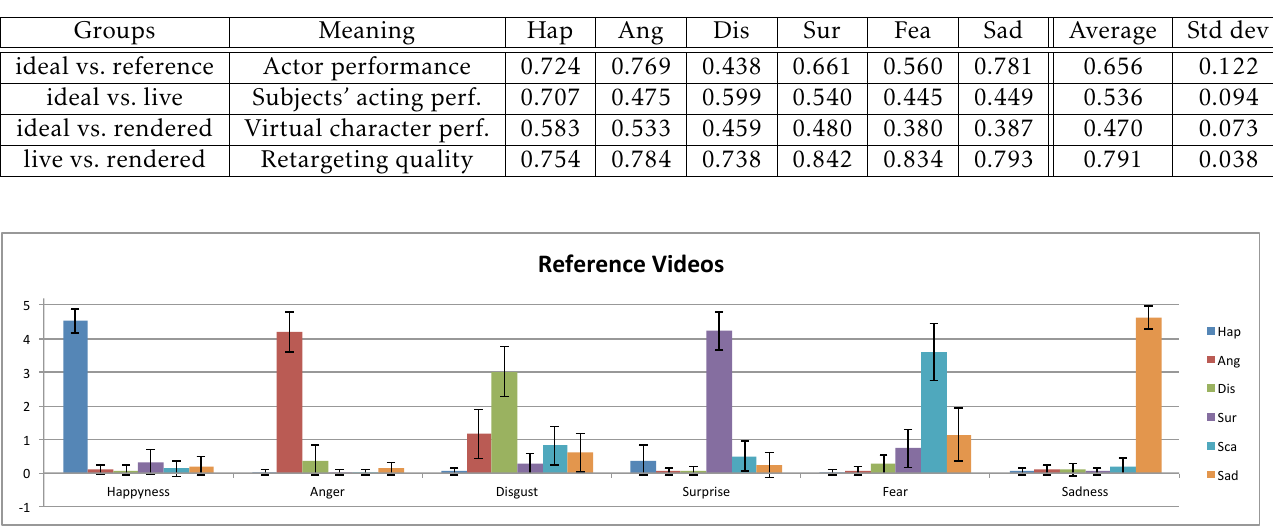
Table 3. The Jaccard coefficient between selected couples of video types.